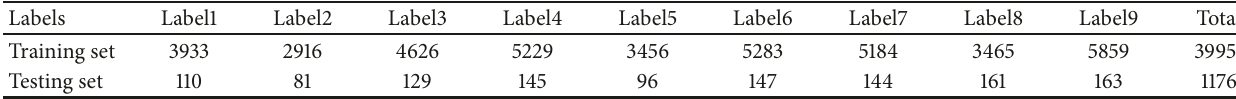
Table 2: The final tomato leaf dataset.